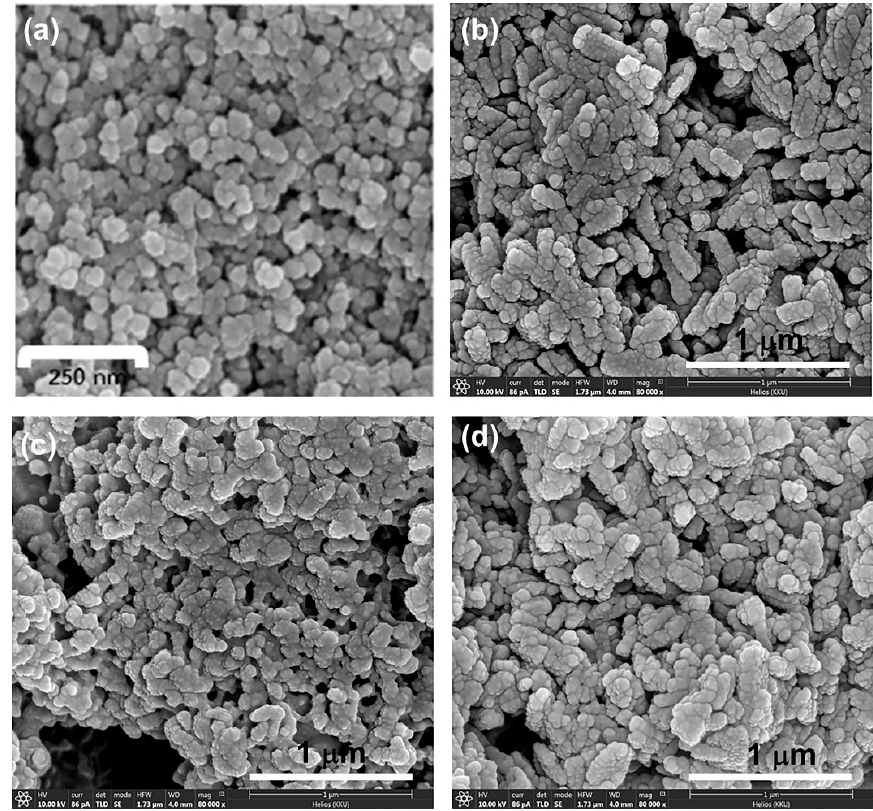
Figure 2. ( a ) SEM image of ZnO NPs, ( b ) FIB-SEM images of ZnO NPs-GABA, ( c ) ZnO NPs-GABA-CurBF 2 , and ( d ) ZnO NPs-GABA/CurBF 2 -AgNPs.